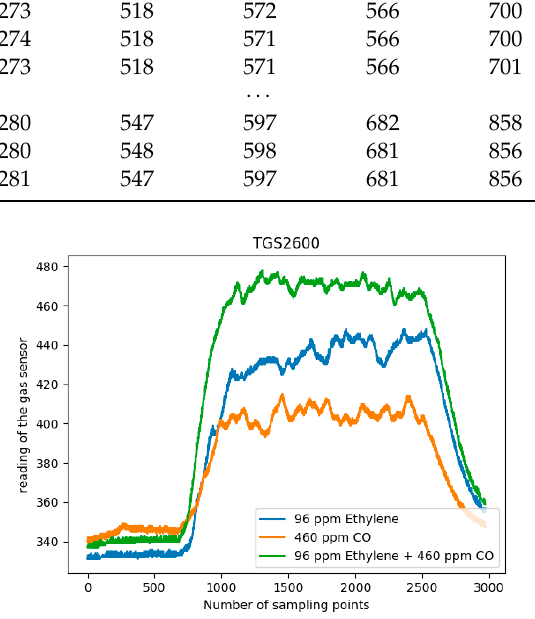
Figure 2. TGS2600 sensor response process curve for single and mixed gases.